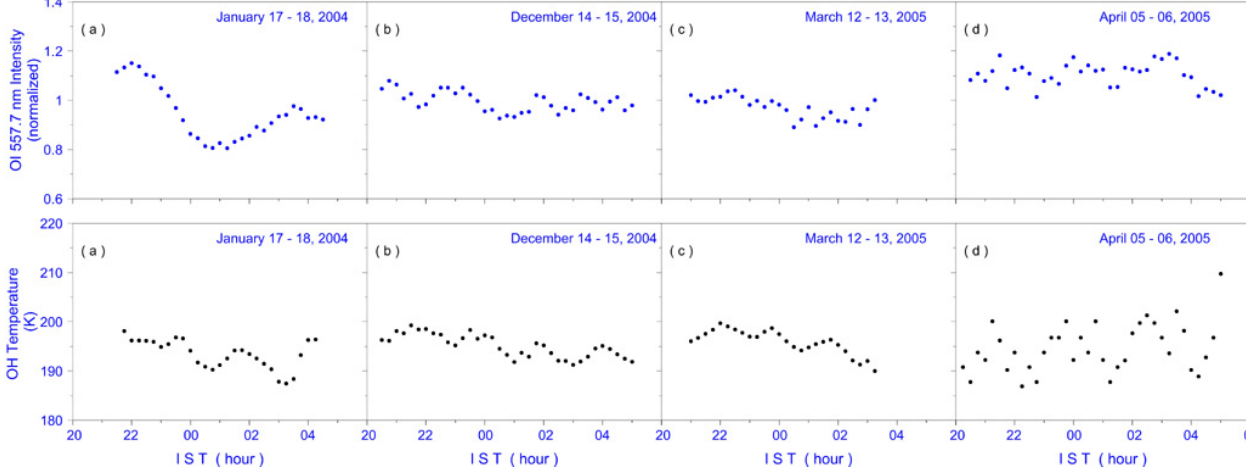
Fig. 4. Examples of gravity wave induced variations in OI 557.7nm intensity (top row) and the OH temperature (bottom